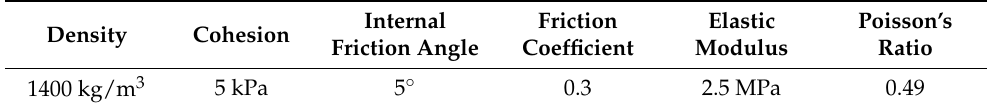
Table 6. Physical and mechanical characteristics of the soil model. Density Cohesion